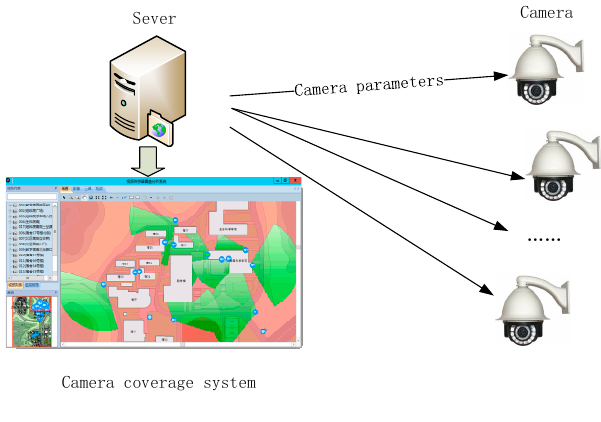
Figure 5. System prototype.